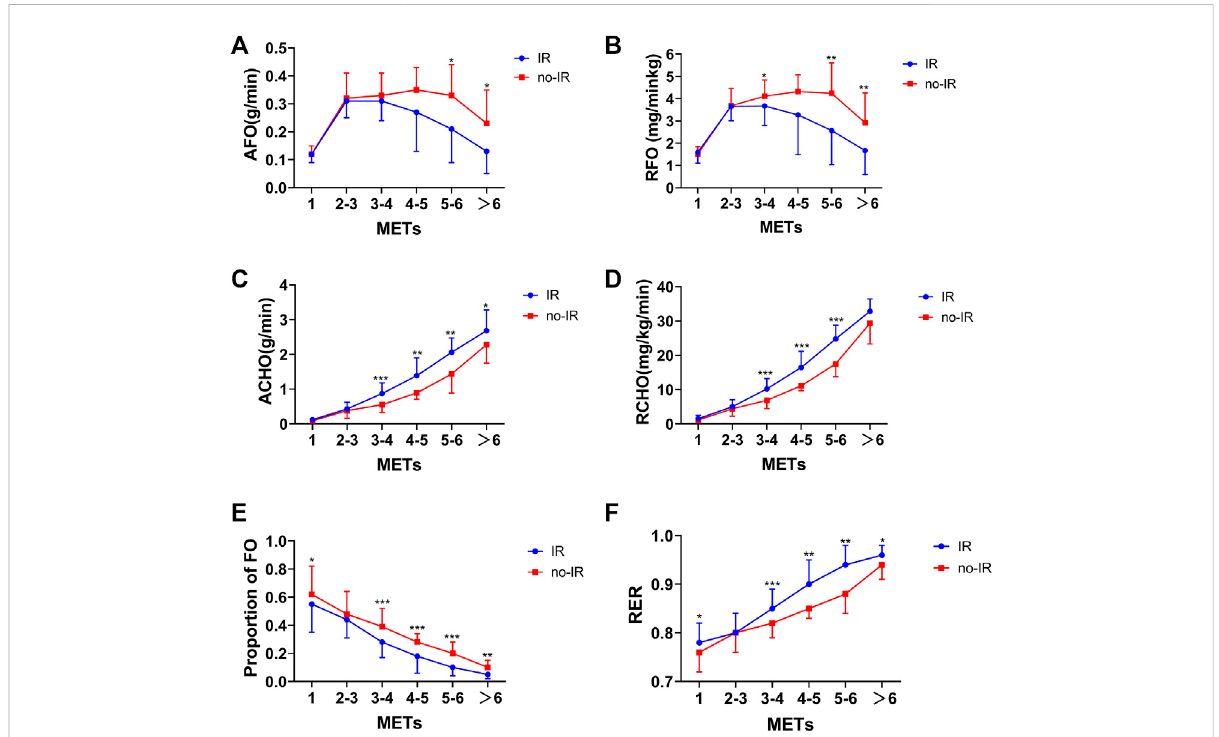
FIGURE 3 Fat and carbohydrate oxidation response to incremental treadmill test in IR and no-IR groups. Line graph of metabolic characteristics at different intensities. (A) : AFO response to incremental treadmill test in IR and no-IR groups; (B) : RFO response to incremental treadmill test in IR and no-IRgroups; (C) :Absolutecarbohydrateoxidation(ACHO)responsetoincrementaltreadmilltestinIRandno-IRgroups; (D) :Relativecarbohydrate oxidation(RCHO)responsetoincrementaltreadmilltestinIRandno-IRgroups; (E) :ProportionofFOduringincrementaltreadmilltest; (F)